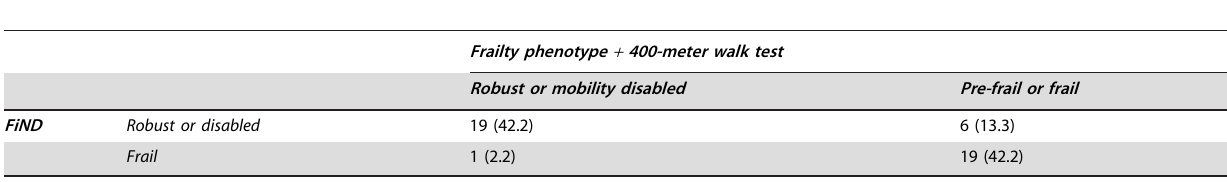
Table 4. Comparison of results aimed at isolating frail non-disabled participants (thus potential candidates to preventive interventions against disability) with the FiND questionnaire versus the combination frailty phenotype and 400-meter walk